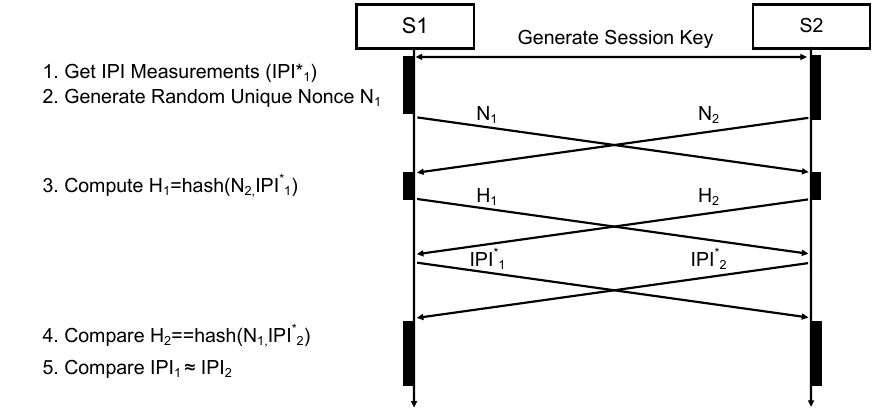
Figure 12. Message sequence chart for the biometric authentication protocol between Sensor nodes S 1 and S 2 , with processing steps for S 1 . The authentication is successful if the last two steps